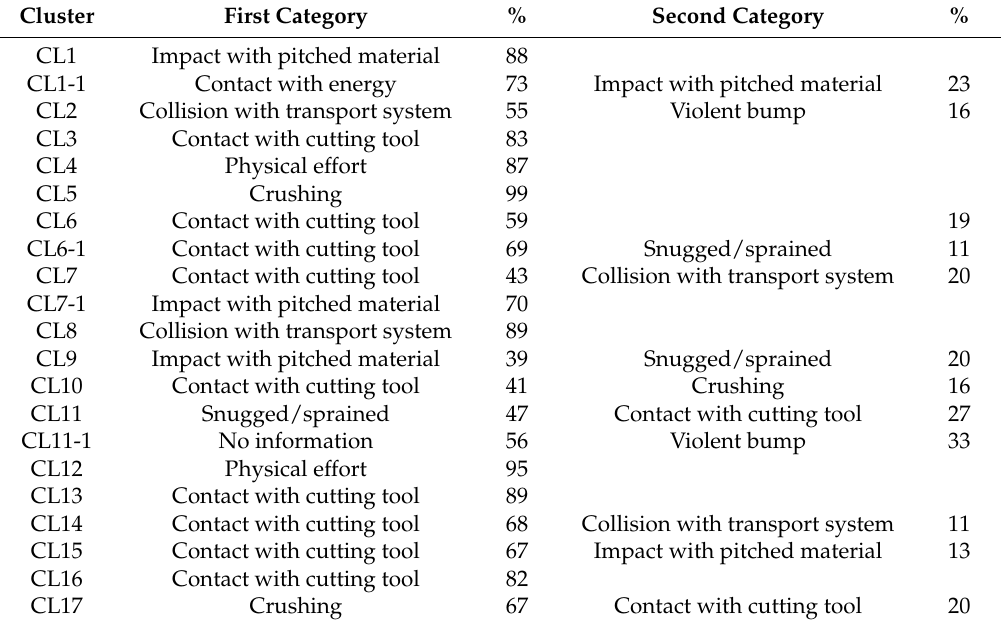
Table A5. Clusters description